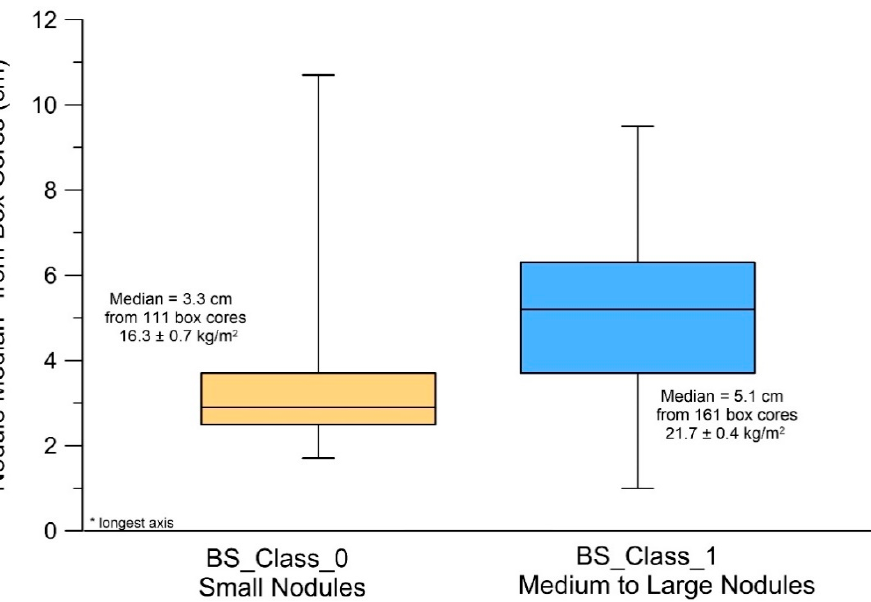
Figure 12. Box-and-whisker plots of the nodule medians in 272 box cores that were located either in the hydro-acoustic class “small nodules” or in the hydro-acoustic class “medium to large nodules”.